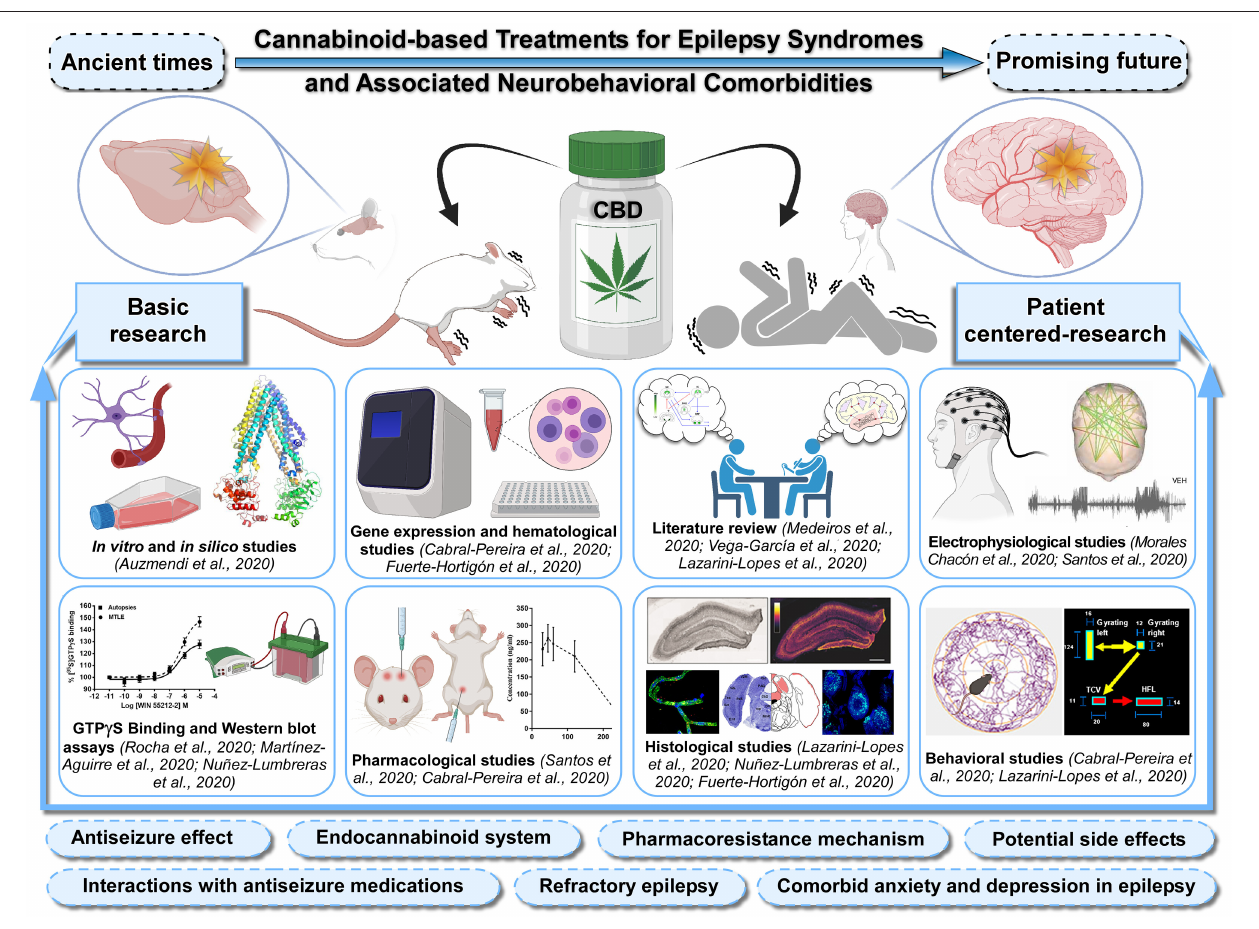
FIGURE 1 | Sketch of the Research Topic’s main issues. Advances in the knowledge of cannabinoid-based treatments for epilepsy syndromes and associated neurobehavioral comorbidities should be fostered by greater integration between basic and patient-centered research. This Special Research Topic brings together scientific studies in experimental models and patients with epilepsy using a broad range of cutting-edge techniques, including molecular, histological, electrophysiological, pharmacological, and behavioral approaches as well as in silico and in vitro methodologies. In addition, it also contains integrative literature reviews that generate new frameworks and perspectives on the topic. This Topic collectively provides a comprehensive insight into the anticonvulsant effects of cannabidiol (CBD), role of the endocannabinoid system, pharmacoresistance mechanisms, potential interactions with classic antiseizure medications, possible side effects, with a view to tackle the use of cannabinoids in refractory epilepsy as well as comorbid anxiety and depression in epilepsy. Articles shown in the figure were grouped by methods and experimental approaches. Figure created with Canvas Software and icons based on Biorender.com